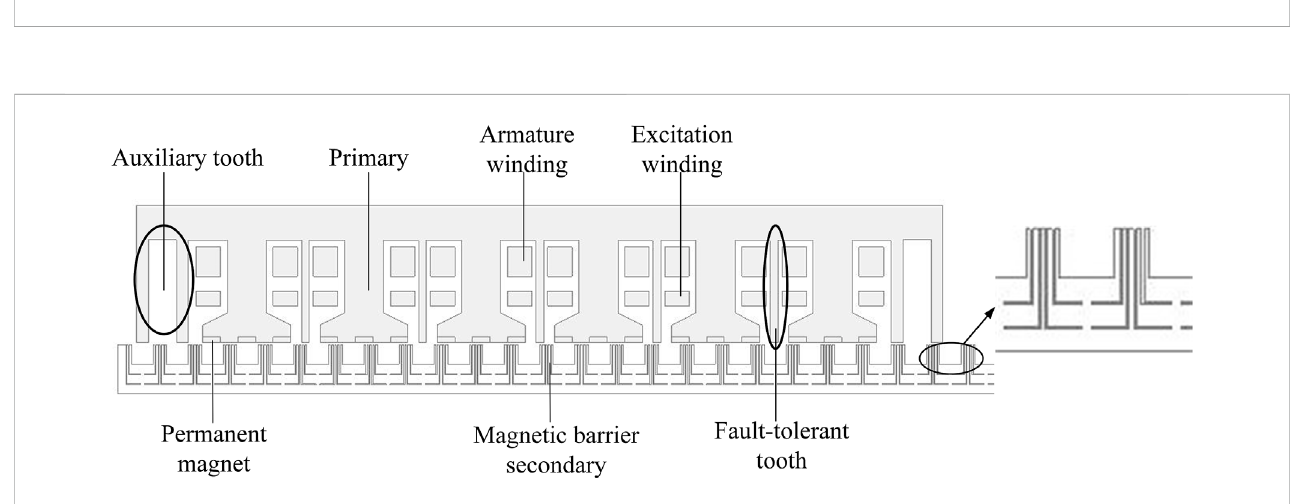
FIGURE 2 Flux-enhancing and fl ux-weakening condition.